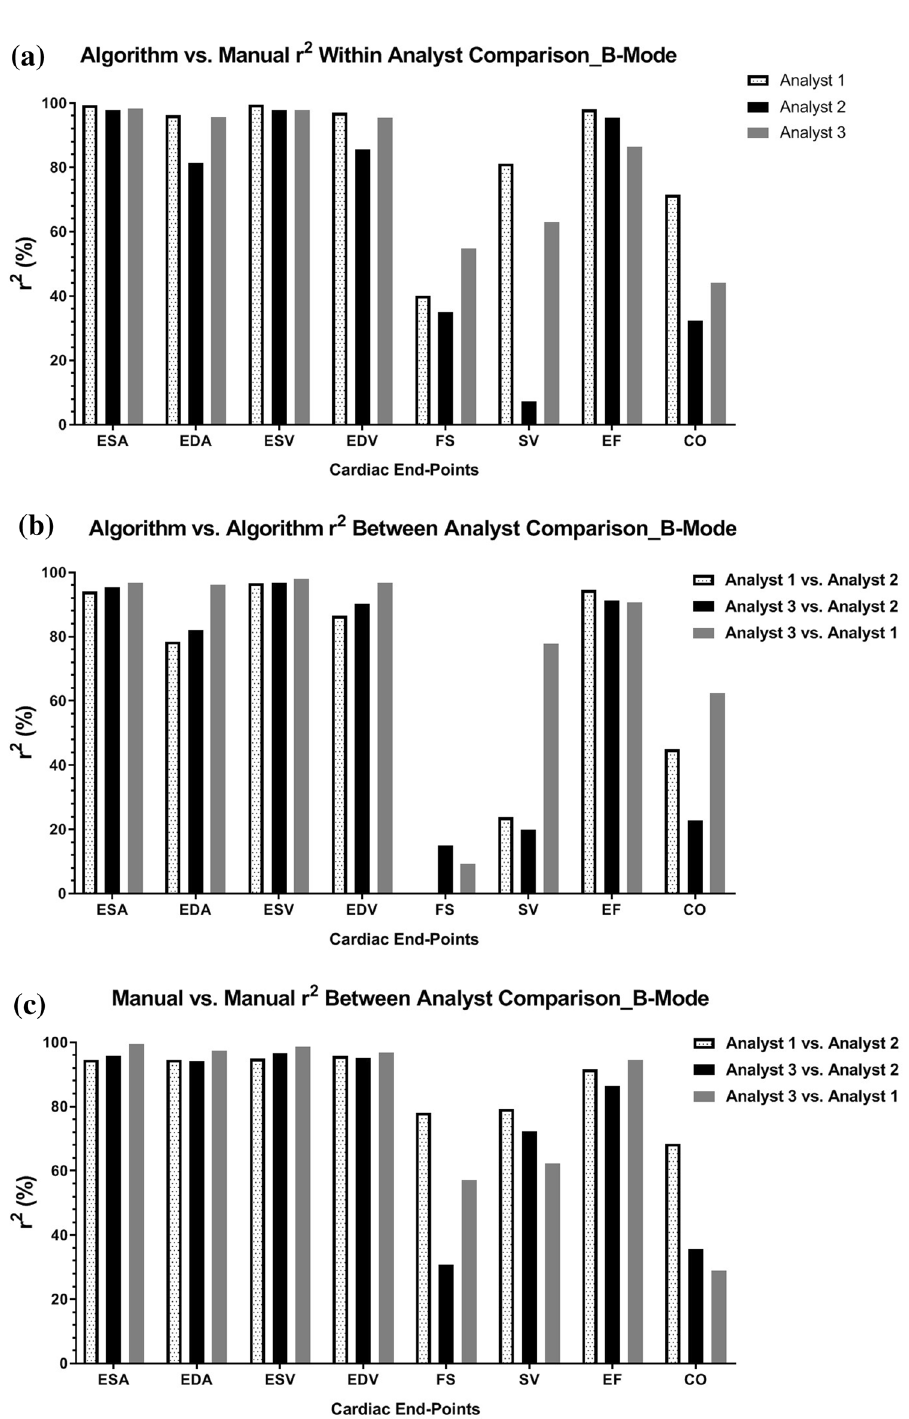
Figure 2. B-mode Segmentation Comparisons: Graphical representations of B-mode coefficient of determination (r 2 ) among three analysts, with r 2 values on the y-axis, and long axis LV structure and function end-points on the x-axis. ( a ) Displays the within analyst comparison of left ventricle B-mode echocardiograms segmented using the semi-automated algorithm compared to manual segmentation; ( b ) shows the between analyst comparison while employing the algorithm for segmentation; and ( c ) shows the between analyst comparison when manual segmentation is performed; p values set at p <